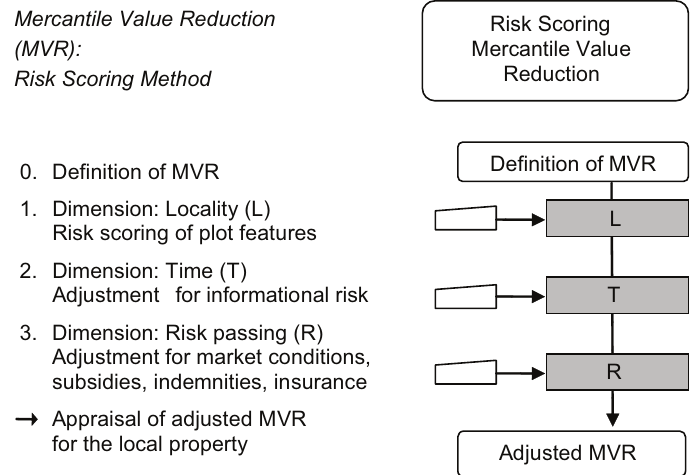
figure 3. Risk scoring concept to determine a MVR